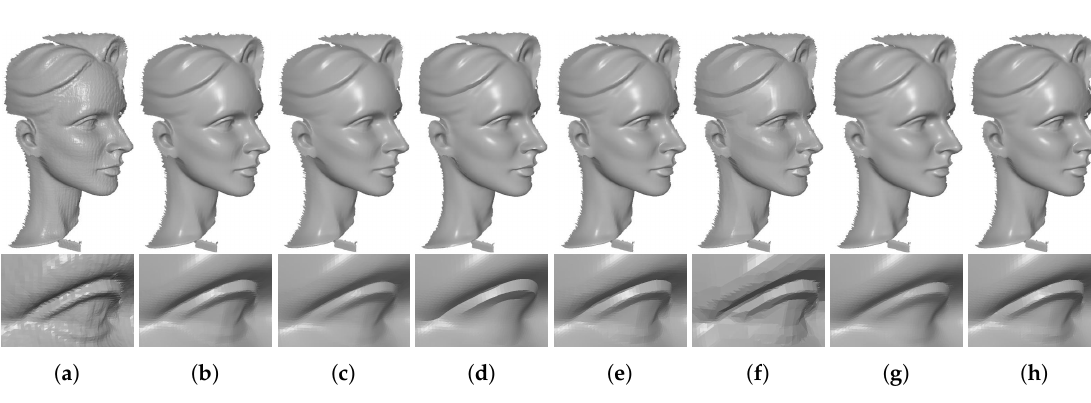
Figure 7. Denoising results of Wilhelm acquired by the laser scanner. From left to right: ( a ) noisy mesh, denoising results produced by ( b ) our method TS; ( c ) HO [1]; ( d ) RHM [14]; ( e ) TV [21]; ( f ) (cid:96) 0 [20]; ( g ) localBF [12]; and ( h ) globalBF [12], respectively. The second row shows the zoomed-in